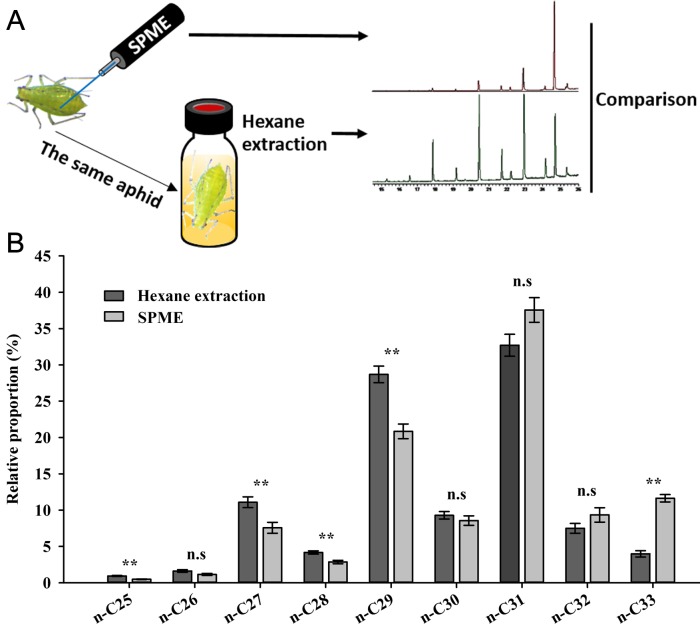
Comparison of CHC profiles of A. pisum achieved from SPME and hexane extraction.(A) Schematic diagram of experimental procedures for CHCs extraction. CHCs were first extracted with non-destructive SPME, and the same aphid (wingless adult of the GNY morph) was used again for CHCs collection with hexane. (B) Relative proportions of nine CHCs extracted with SPME and hexane. Wingless GNY adults were used. Error bars represent s.e.m of six biological replicates. n.s denotes not significant. * P < 0.05, ** P < 0.01 (Student’s t-test).